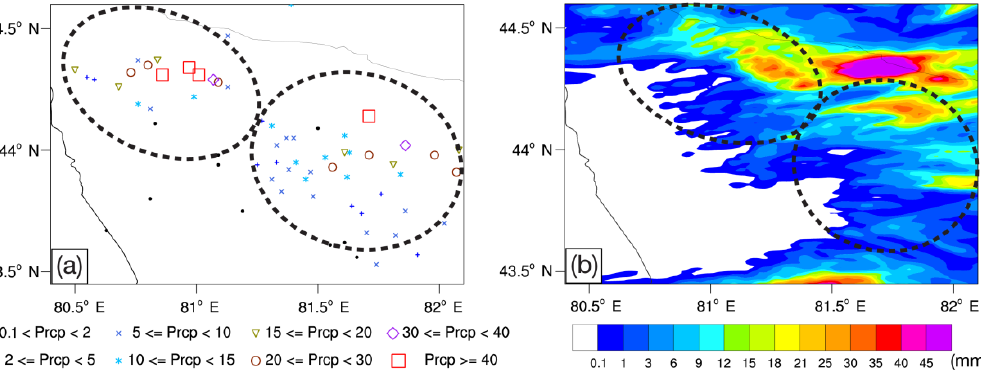
Figure 8. ( a ) 6-h accumulated precipitation (colorful symbols, units: mm) observed by the ground-based automatic weather stations from 1000 to 1600 UTC 17 June 2016. ( b ) Simulated 6-h accumulated precipitation (shading, units: mm) 1000 to 1600 UTC 17 June 2016.